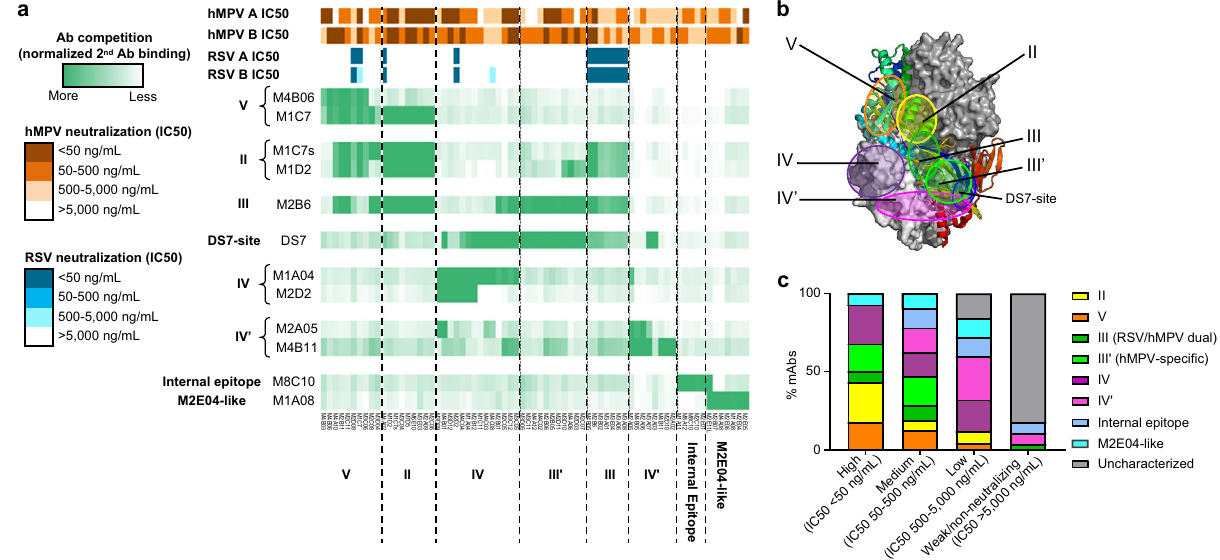
Fig. 4 Epitope mapping of hMPV F-speci fi c mAbs by BLI binning. a Epitope binning of selected mAbs with the unprocessed hMPV PreF antigen. Seventy- three isolated mAbs which showed apparent BLI binding response (>0.2 nm) with the tested antigen were shown. The heatmap shows epitope binning from the sandwich-based BLI binding assay, with darker green color indicating more competition between the fi rst and the second antibodies. Top side- bars showed the neutralization potency (IC50) of mAbs to hMPV A, hMPV B, RSV A, and RSV B virus strains. b Major antigenic sites II, III, III ′ , IV, IV ′ , V were mapped on the hMPV PreF trimer protein structure. DS7-site was also labeled as a reference. c Percentage of antibodies targeting each antigenic site, grouped by neutralization potency. For each mAb, the stronger neutralization potency of hMPV A and B were chosen for grouping. Source data are provided as a Source Data fi